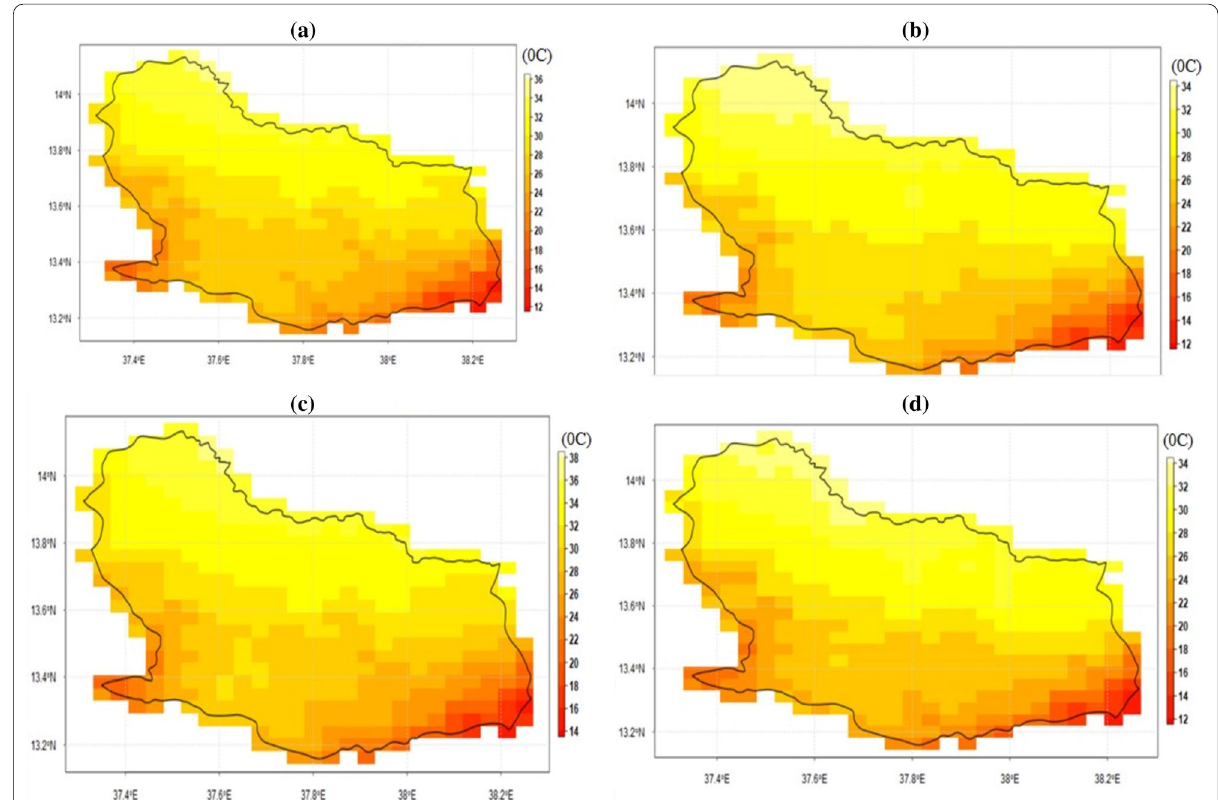
Fig. 10 Annual and seasonal mean maximum temperature Annual ( a ), Bega season ( b ), Belg season and ( c ) Kiremit season of Zarima